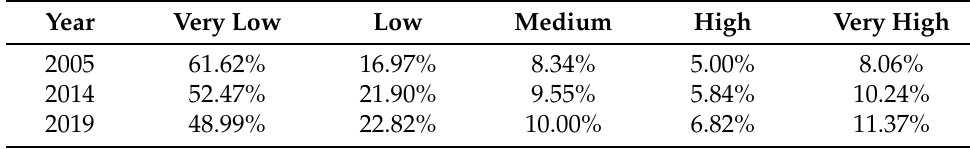
Table A5. Changes in the percentage of the different exposure levels from 2005–2019 (%).